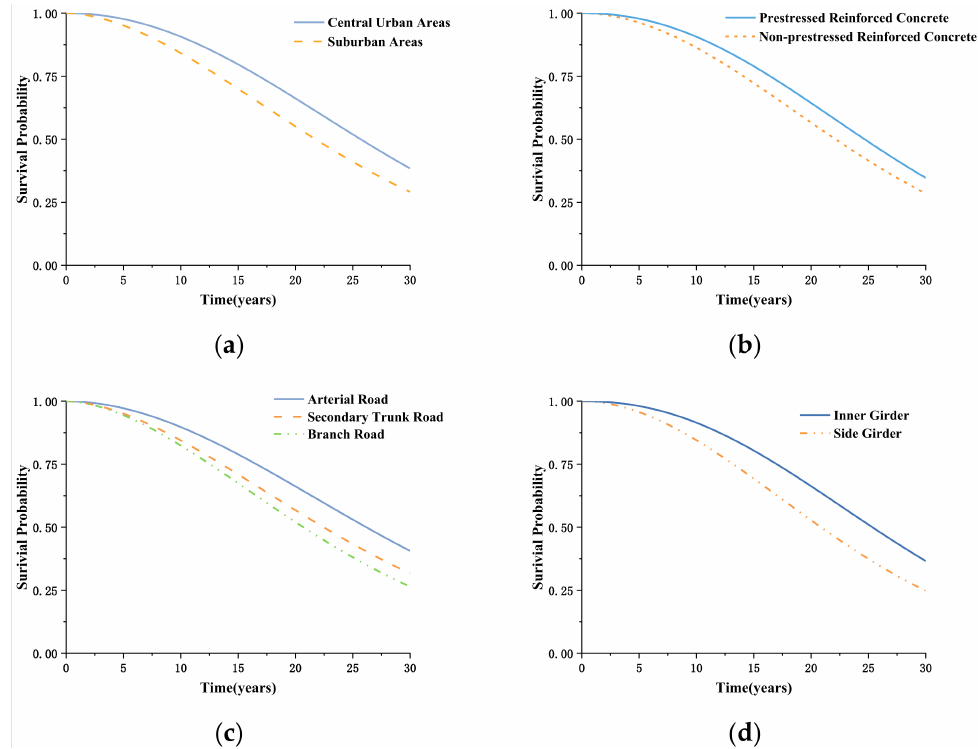
Figure 2. The influence of different covariates on the survival curve. ( a ) area factor; ( b ) structure factor; ( c ) road factor; ( d ) position